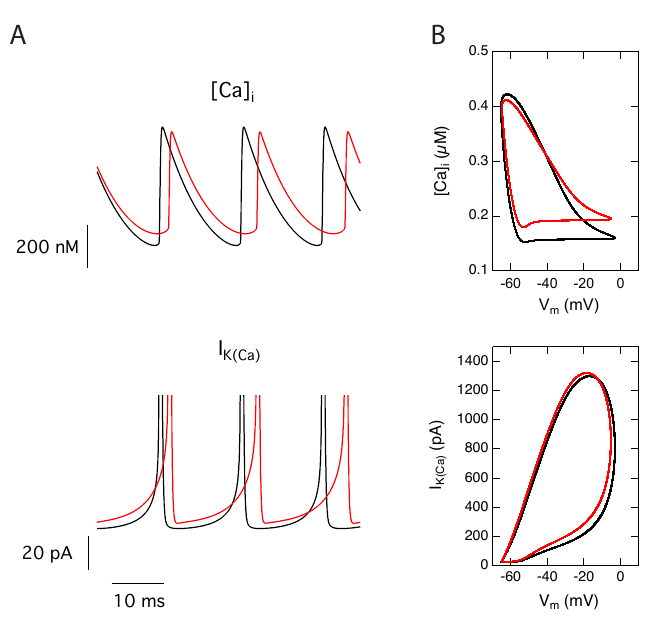
Figure 3. Tonic NMDA-R activity enhances calcium-activated potassium channels activation during periodic